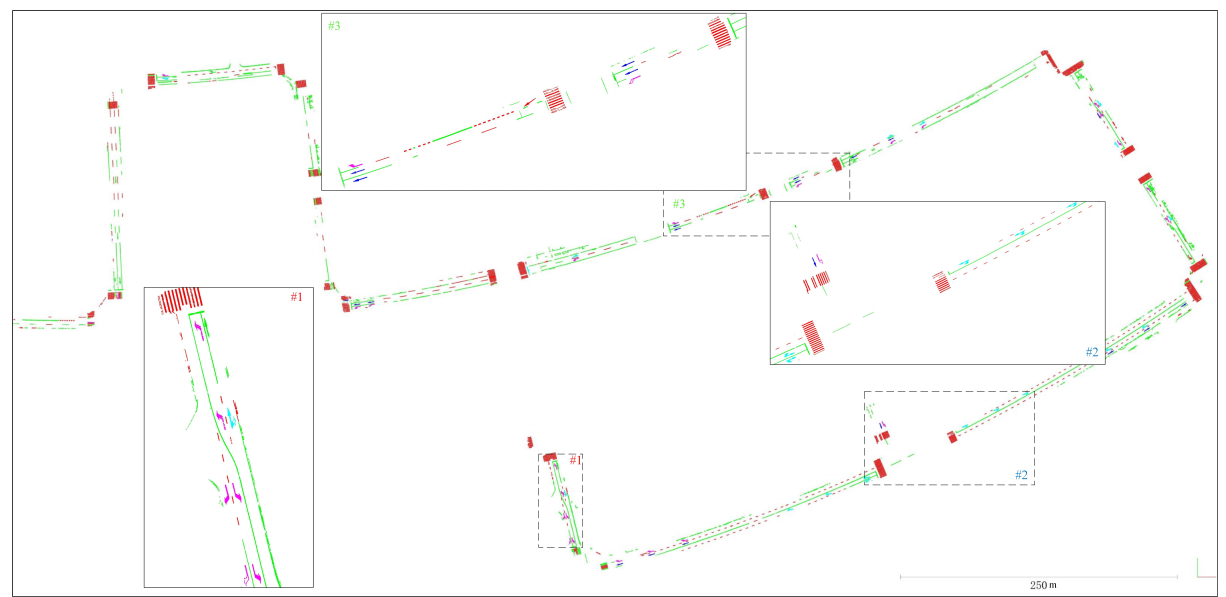
Figure 7. Road markings point clouds detection and classification result for the Urban road 1 dataset